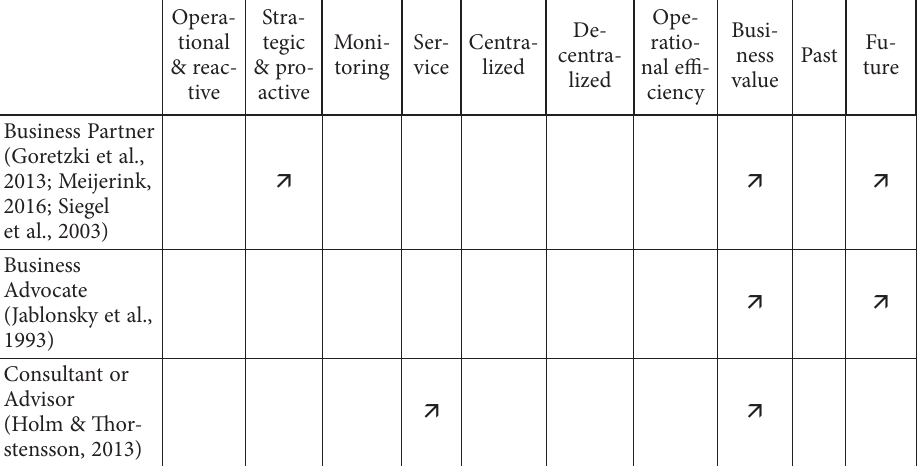
Ser- Centra- vice lized